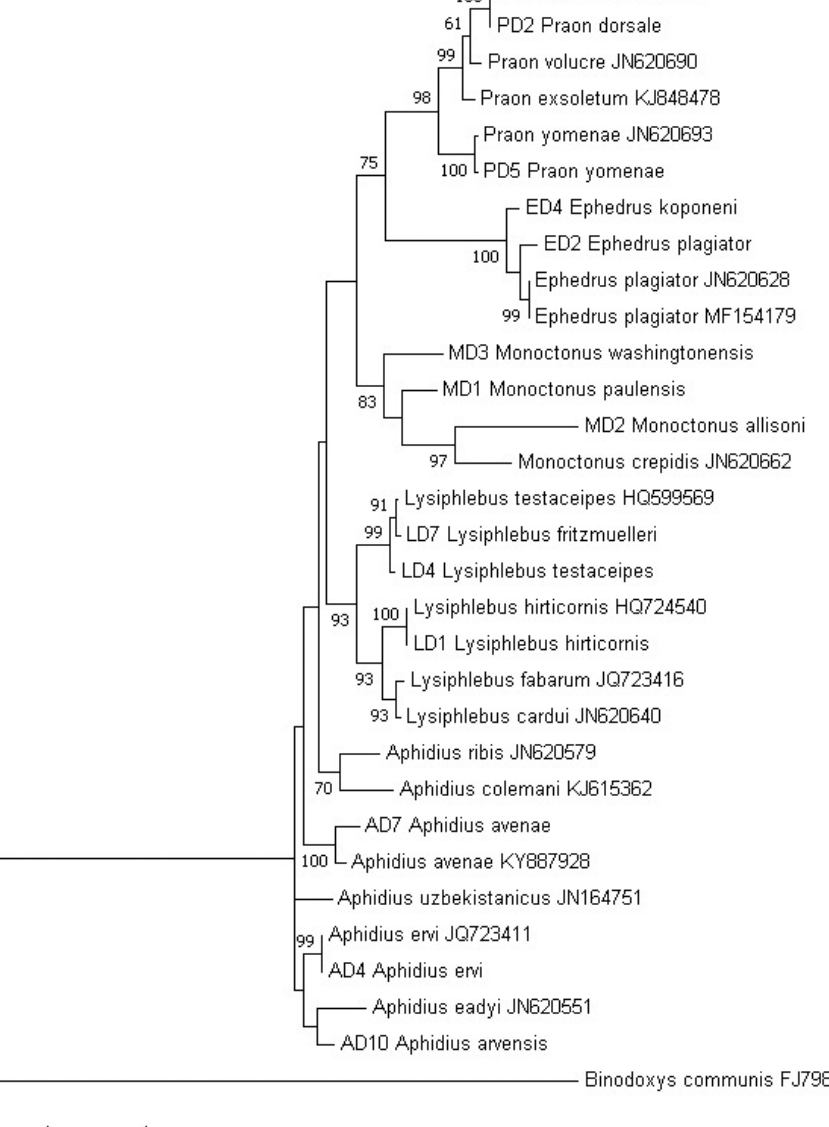
Figure 8. The evolutionary history was inferred by using the Maximum Likelihood method based on the Tamura-Nei model. The tree with the highest log likelihood is shown. There were a total of 568 positions in the final dataset. Initial tree(s) for the heuristic search were obtained automatically by applying Neighbor-Join and BioNJ algorithms to a matrix of pairwise distances estimated using the Maximum Composite Likelihood (MCL) approach, and then selecting the topology with superior log likelihood value. The tree is drawn to scale, with branch lengths measured in the number of substitutions per site. The percentage of replicate trees >50% in which the associated taxa clustered together in the bootstrap test (500 replicates) are shown next to the